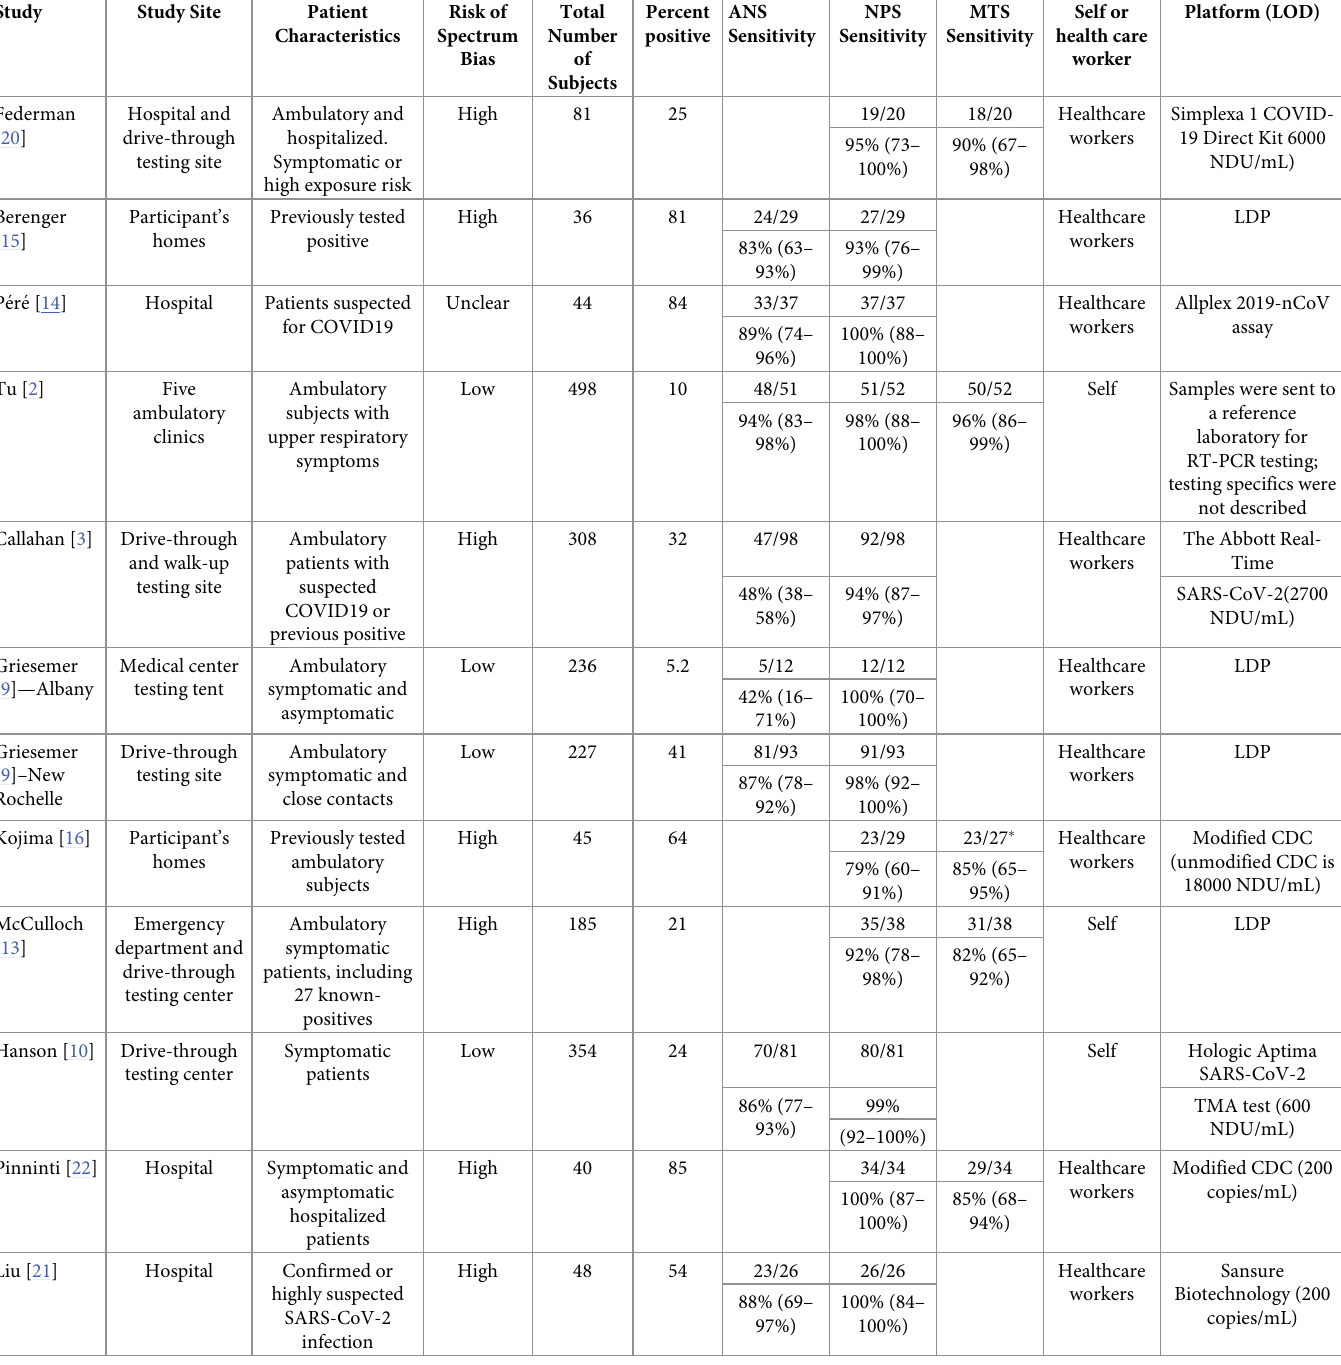
Table 1. Study characteristics and relative sensitivity of anterior nares, nasopharynx, and mid-turbinate